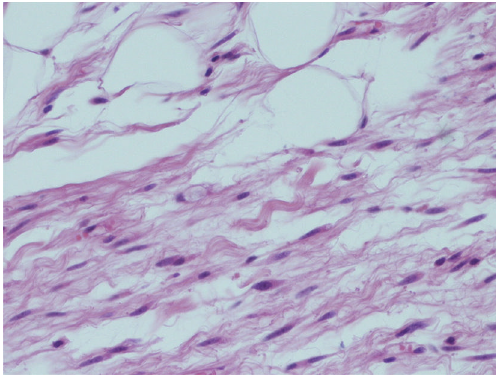
Figure 4: High-power view of fibrous area with ropey collagen bundles and scattered spindle cells (H&E x100).